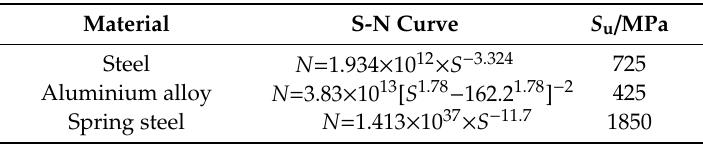
Table 1. Material list